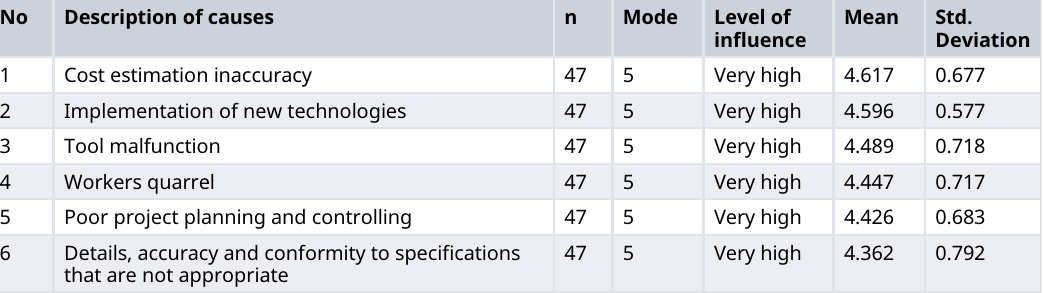
Table 5. Results of descriptive statistics on the level of influence of project delay